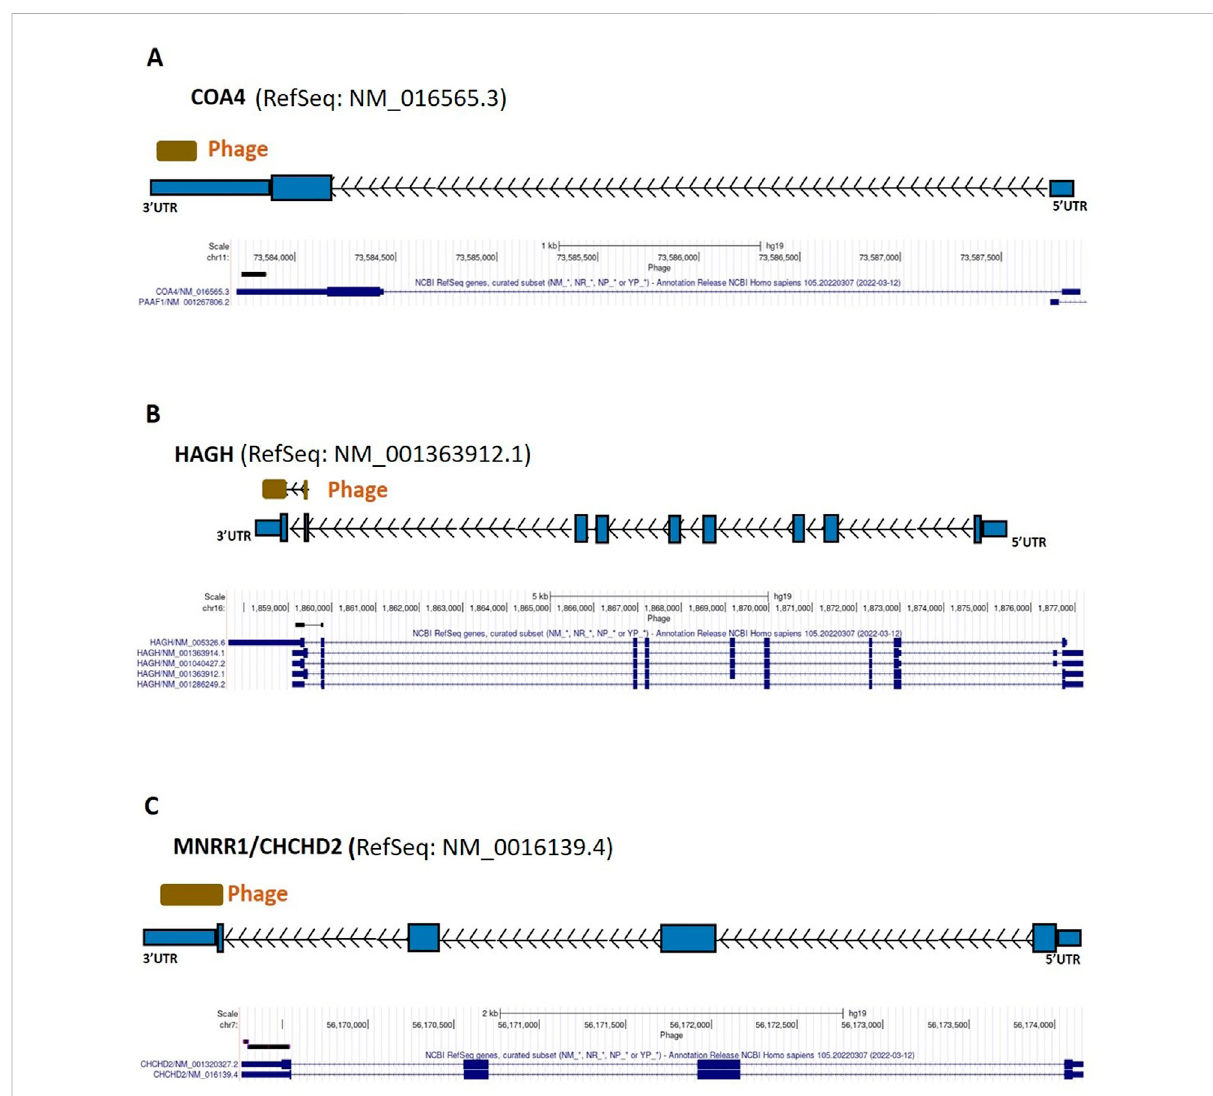
FIGURE 5 COA4 , HAGH , and MNRR1 gene regions as autoreactive BC antigens identi fi ed by UCSC Genome Browser BLAT mapping and annotation of uniquely patient-sera-reactive phages. (A) Identi fi ed phage within 3 ′ -UTR region of COA4 . (B) Identi fi ed phage included protein coding region as wellas3 ′ -UTRregionof HAGH . (C) Identi fi edphageincludedproteincodingregionaswellas3 ′ -UTRregionof MNRR1 ;UTR,untranslatedregion;kb, kilobase; COA4 , cytochrome C oxidase assembly factor 4 homolog; HAGH , hydroxyacylglutathione hydrolase; MNRR1 , mitochondrial nuclear retrograde regulator